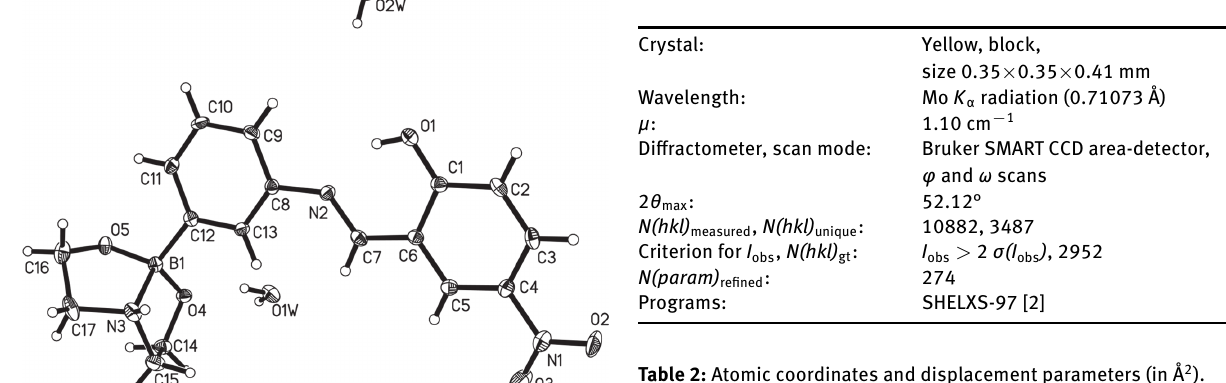
Table 2: Atomic coordinates and displacement parameters (in Å 2